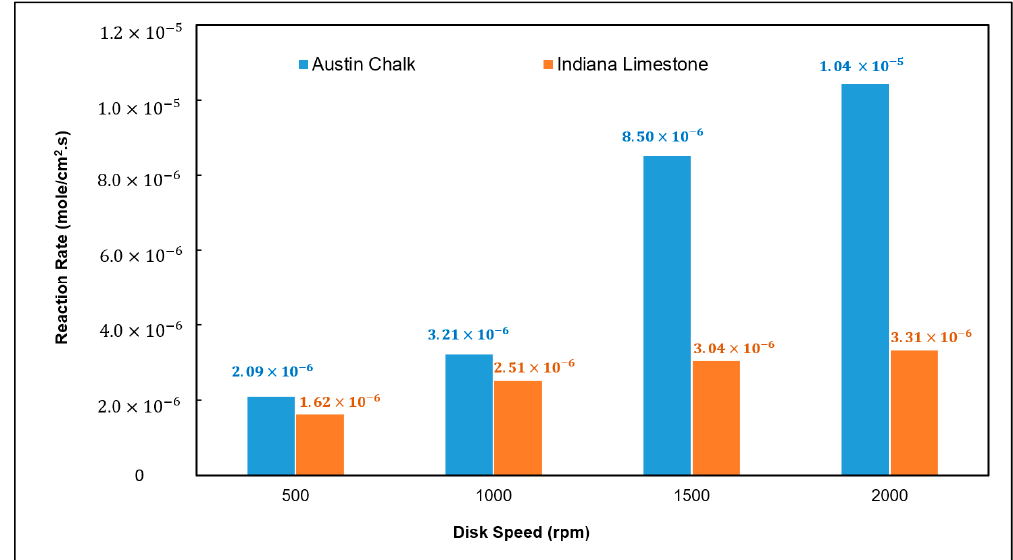
Figure 11. Reaction rated of GLDA/seawater with Austin chalk and Indiana limestone at 200 °F and 1000 psi.